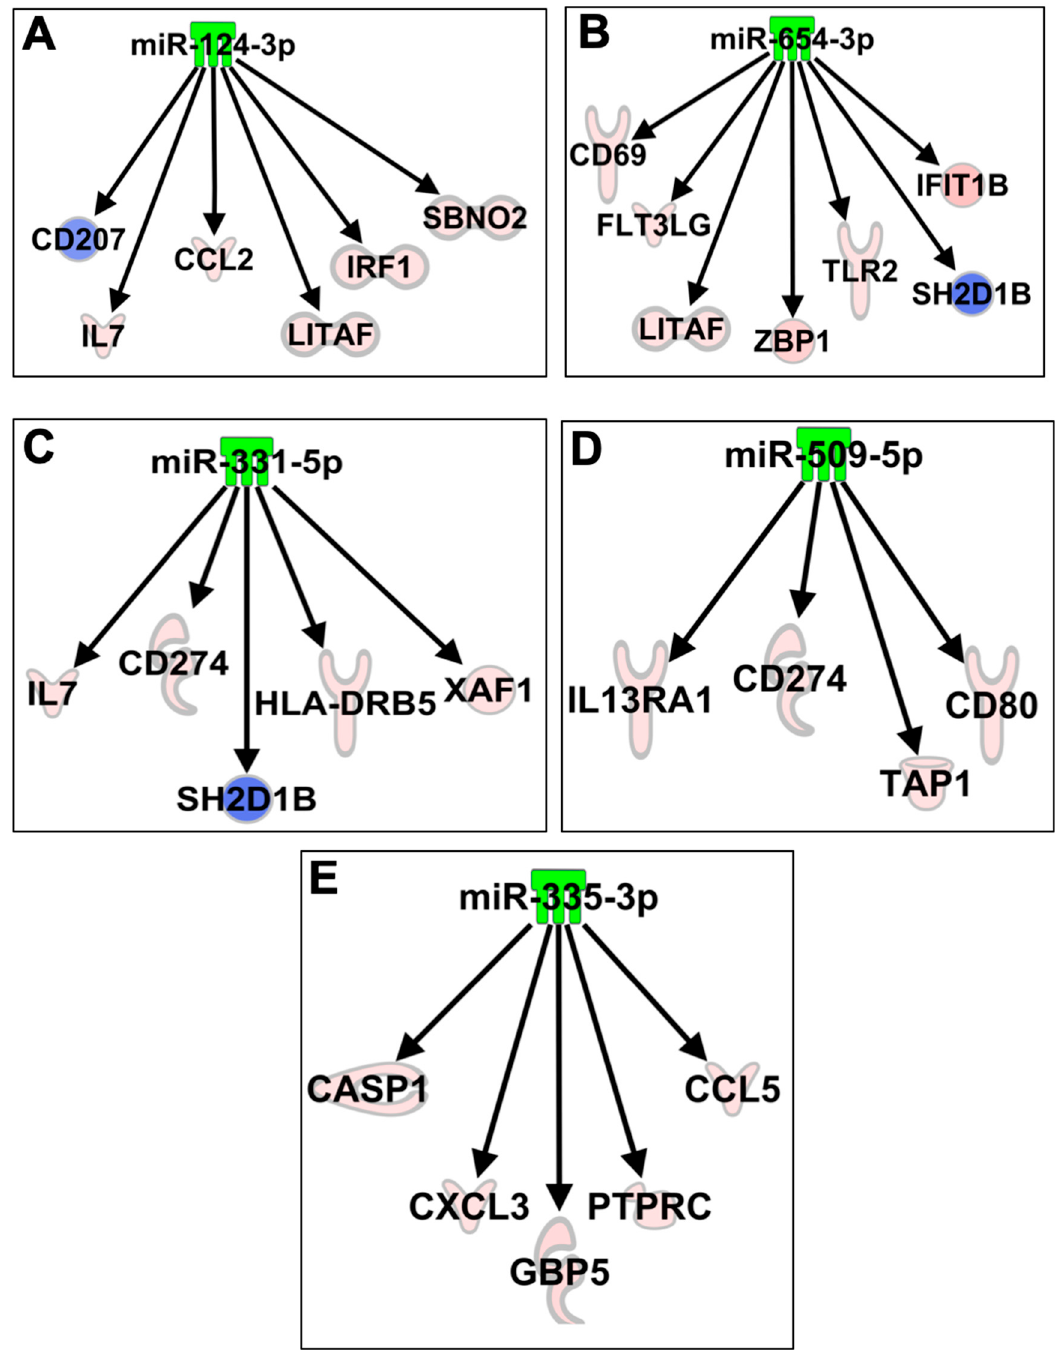
Figure 7. Networks of the interactions of the miRNA target genes. IPA tool was used to generate the miRNA-mRNA interaction network of ( A ) miR-124-3p, ( B ) miR-654-3p, ( C ) miR-331-5p, ( D ) miR-509-5p, and ( E ) miR-335-3p and mRNAs significantly modulated in neurons after ZIKV infection. Red (increased expression) and green (decreased expression).